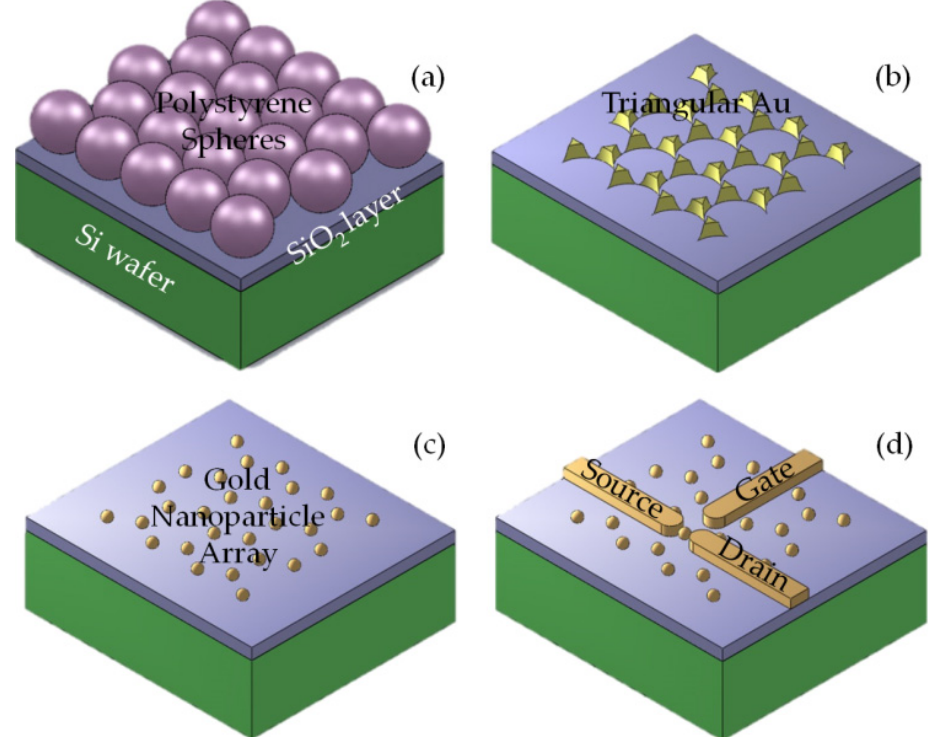
Figure 1. Schematic diagram of the process for SET preparation. ( a ) The PS microsphere monolayer was prepared on Si wafer; ( b ) Triangular gold array was prepared by the PS microsphere template; ( c ) Gold nanoparticle array was prepared by means of solution etching and annealing; ( d ) After 6 nm-thick-SiO 2 was deposited on the gold nanoparticle array, typical electrodes were prepared.